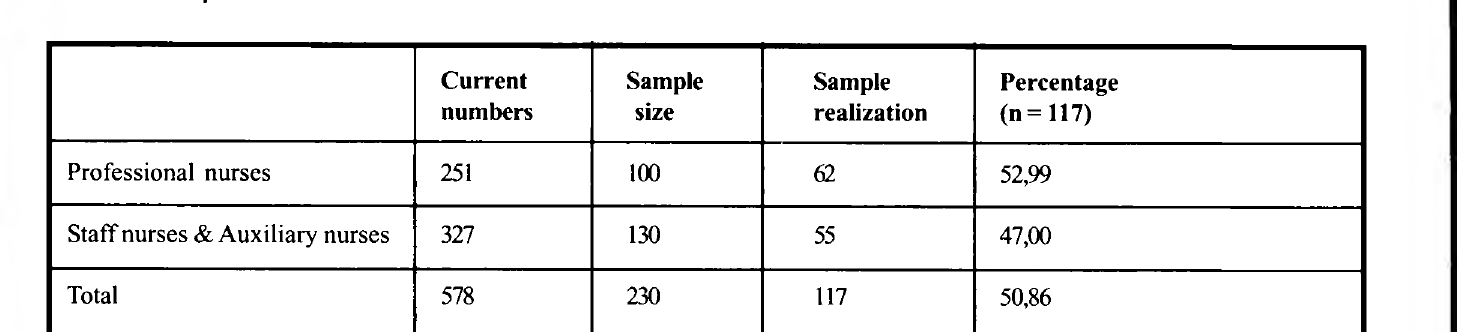
Table 1: Sample size and